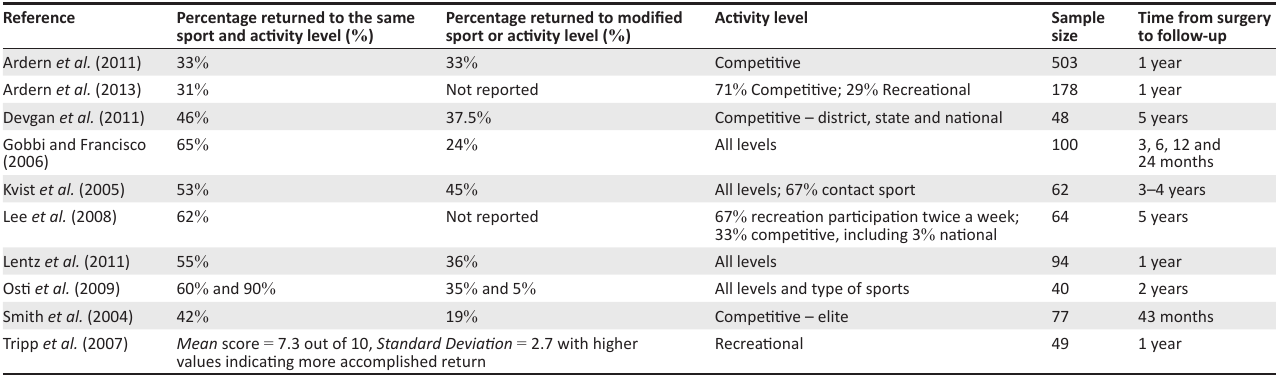
TABLE 2: Sample description for each study included in the systematic review. Reference